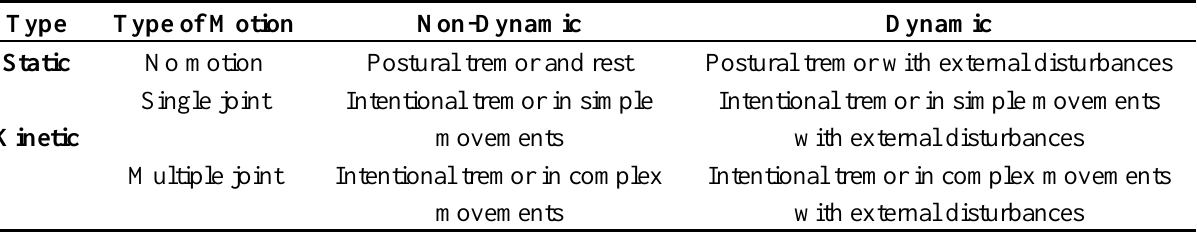
Table 2. Pattern